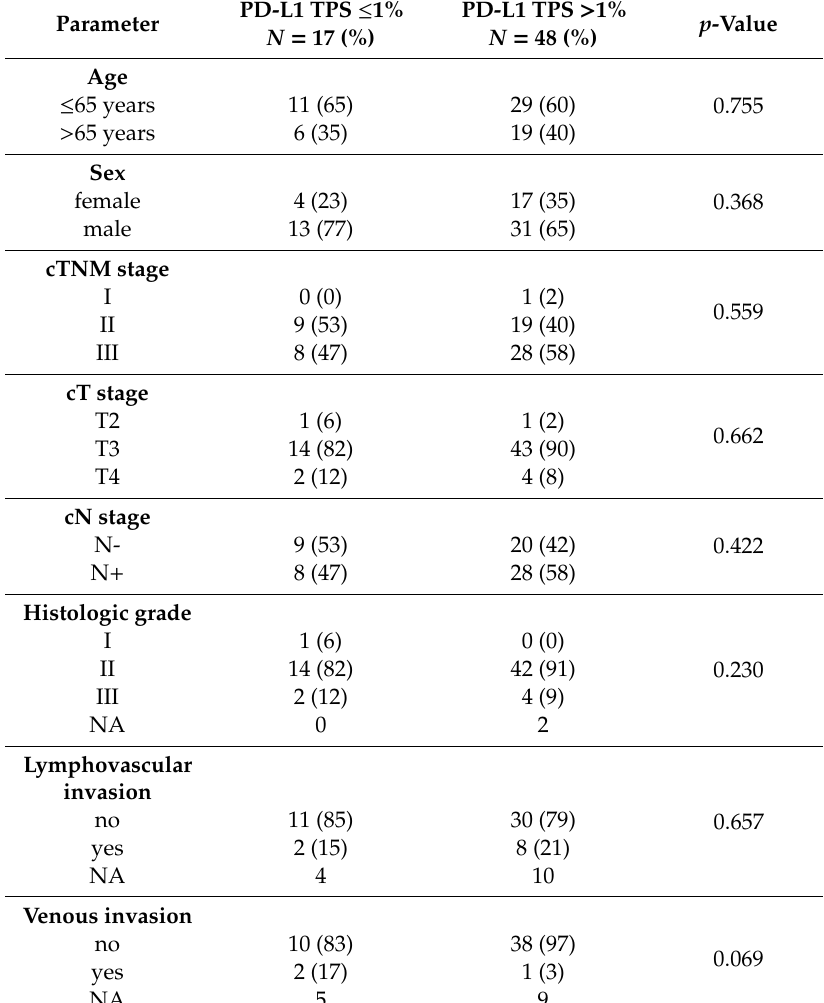
Table A2. Baseline patient and tumor characteristics according to PD-L1 TPS status prior to neoadjuvant